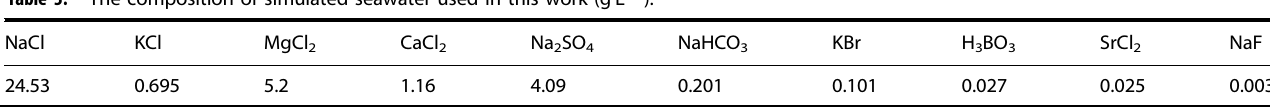
Fig. 10 Schematic diagrams and the setups for electrochemical measurements. a shown for the separation and enrichment of sproes, b the setup for EIS and potentiodynamic polarization curves measurements, c the setup for WBE Table 3. The composition of simulated seawater used in this work (g L − 1 ).